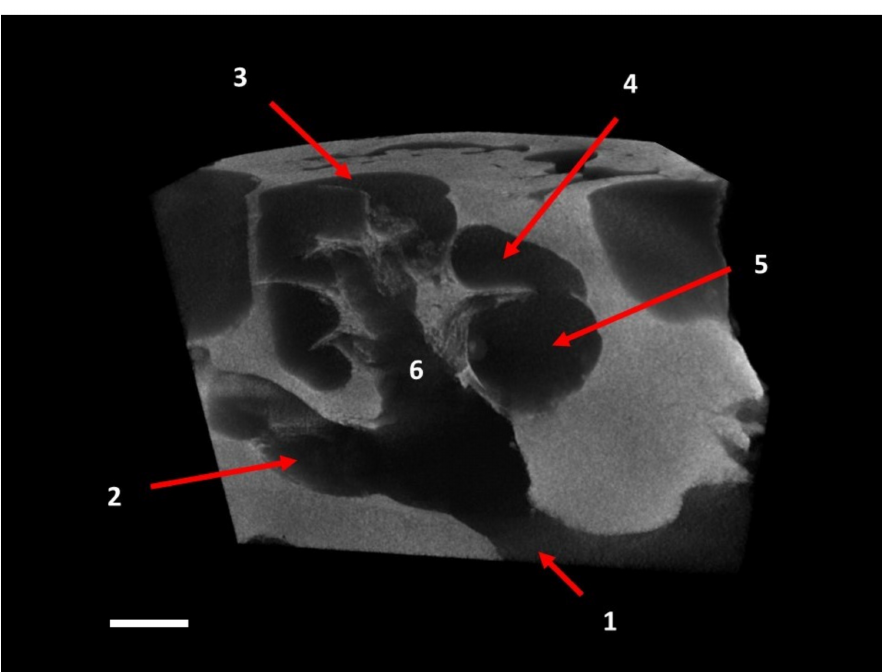
Figure 2. Vertical cross section of the cochlea at level of the modiolus. 1, internal acoustic meatus; 2, beginning of the scala tympani near the round window; 3, last turn; 4, scala vestibuli; 5, scala tympani; 6, bony cavity of the modiolus housing the cochlear nerve (3D reconstruction by µ -CT projections). Scale bar = 1 mm.